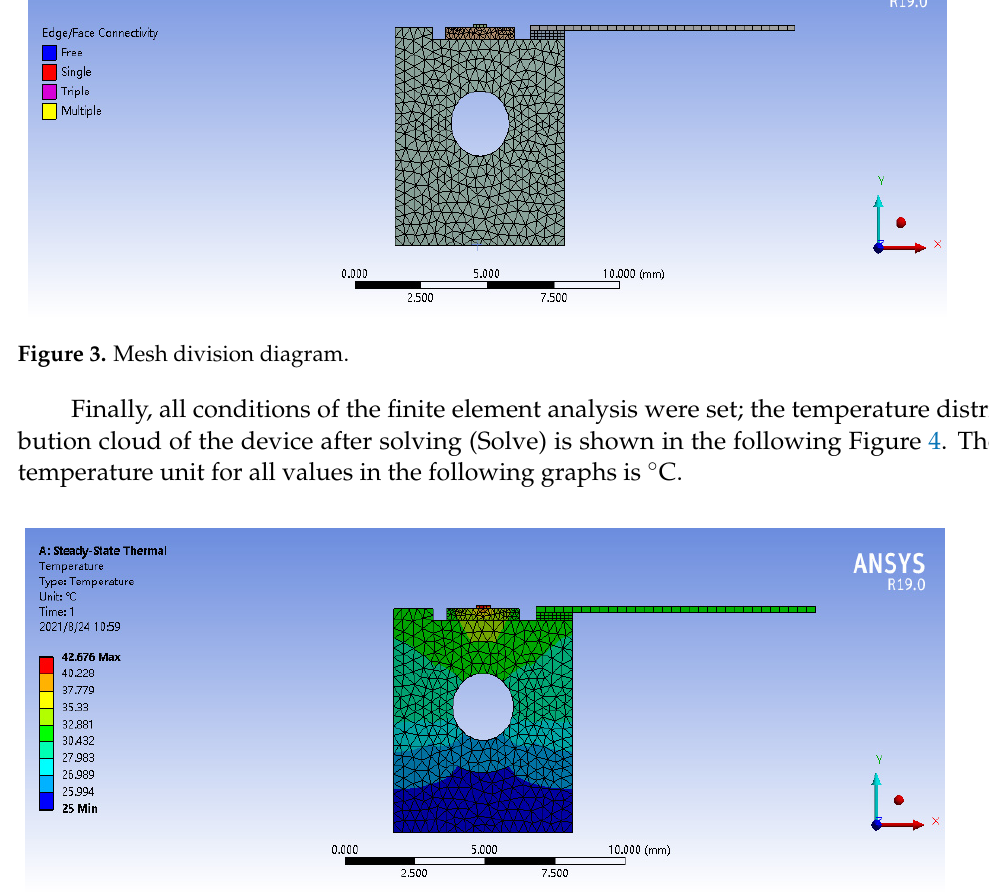
Figure 4. Cloud map of temperature distribution.